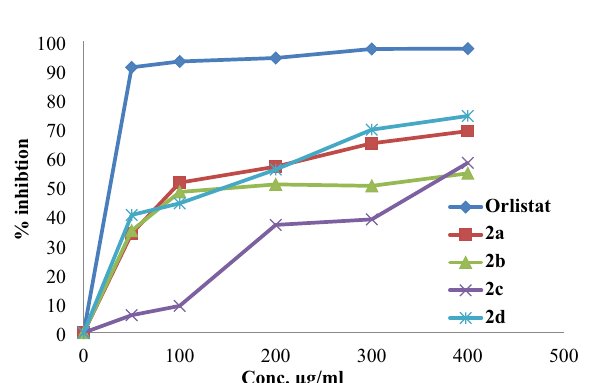
Figure 6. Antioxidant activities of synthesis compounds in β -carotene–linoleic acid test.